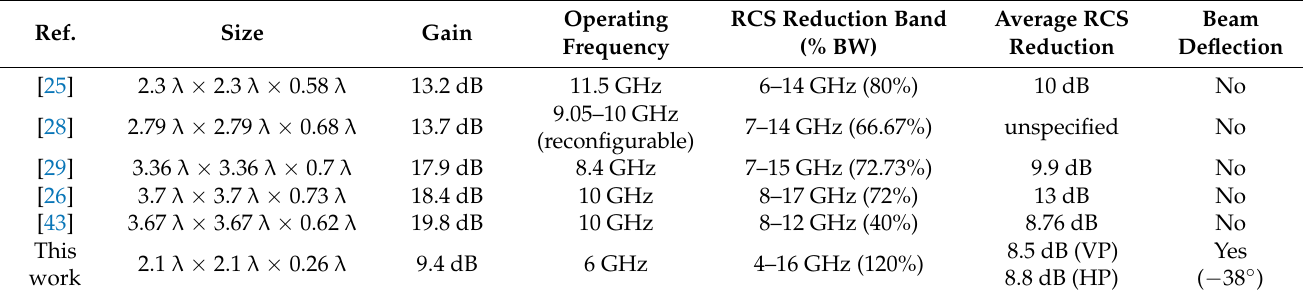
Table 3. Comparison of proposed work with previously reported